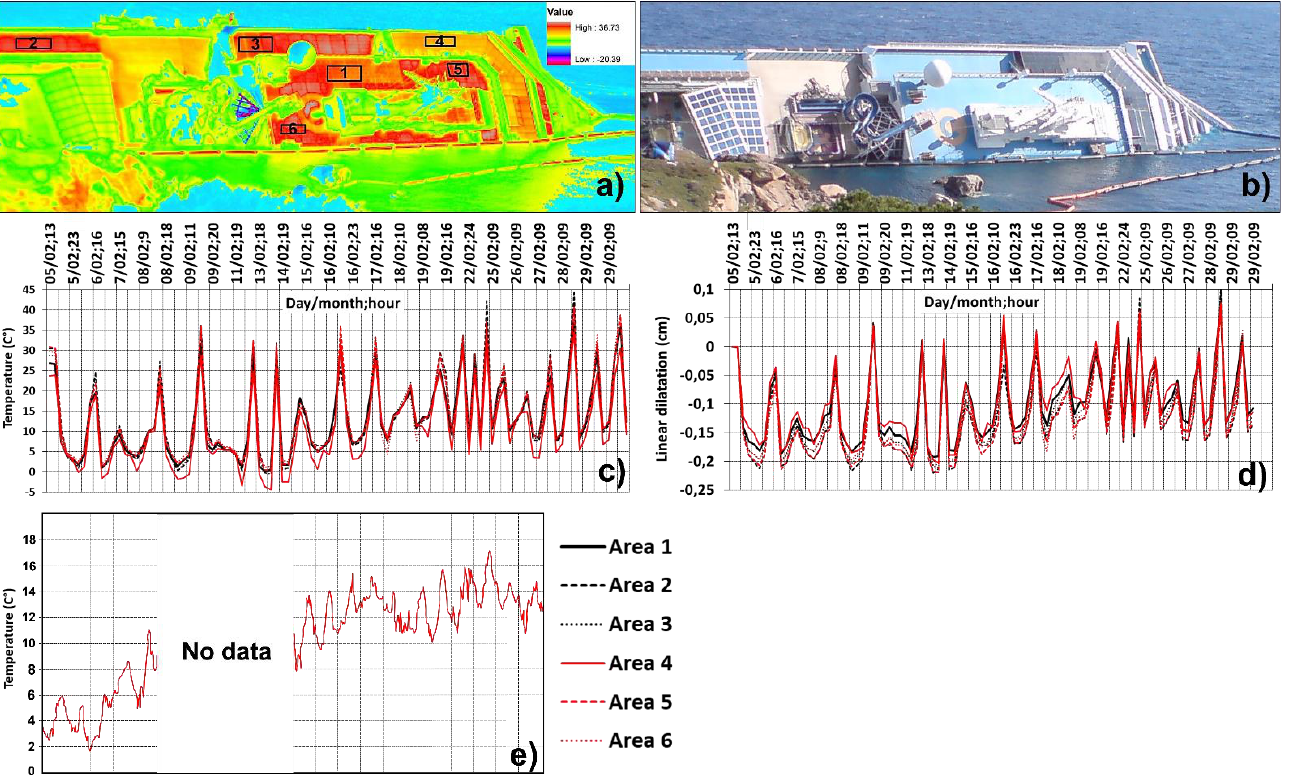
Figure 3. The IRT short-term monitoring campaign from P1: thermographic ∆ T Image of the deck sector with the control areas (1–6) created in ArcMap ( a ); corresponding optical image (see the collapsed glass panels of the deck) ( b ); average surface temperature variations in correspondence of the control areas ( c ); linear thermal dilatation in the control sectors ( d ); air temperature data of the marine weather station of Giglio Porto between 5 and 26 February 2012 ( e ). Time scale of panel ( e ) is the same with respect to subfigures ( c , d ).